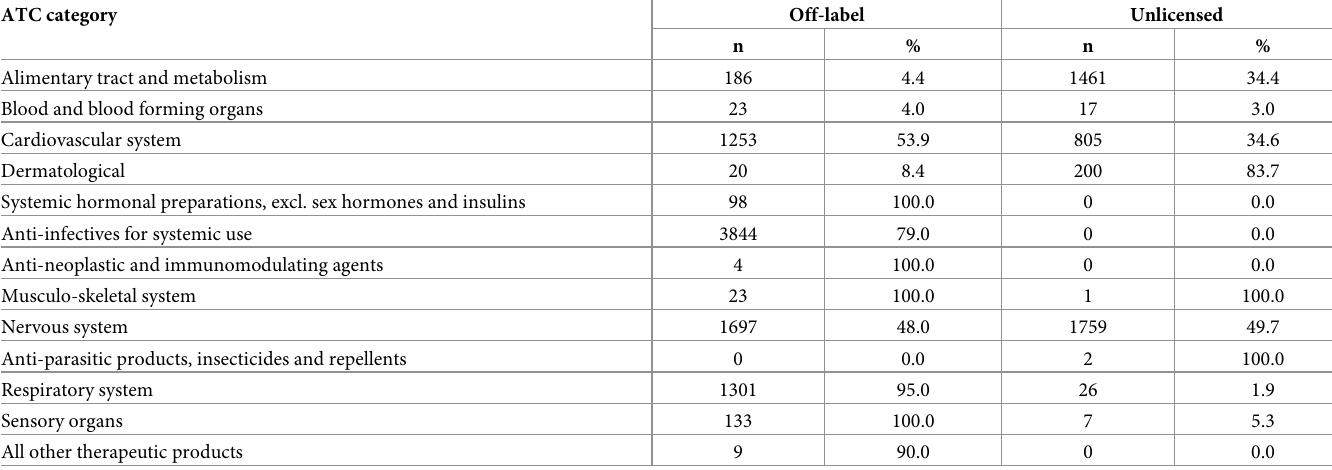
Table 4. Frequency of off-label and unlicensed drug prescription within each ATC